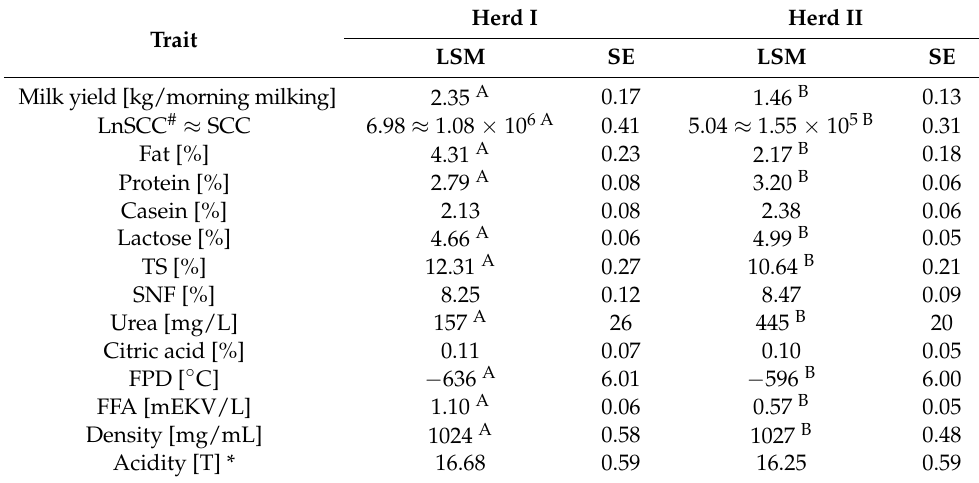
Table 1. The differences in the yield and composition of milk from morning milking between the control groups of the two herds, regardless of the time of sampling. Herd I Herd II Trait LSM SE LSM